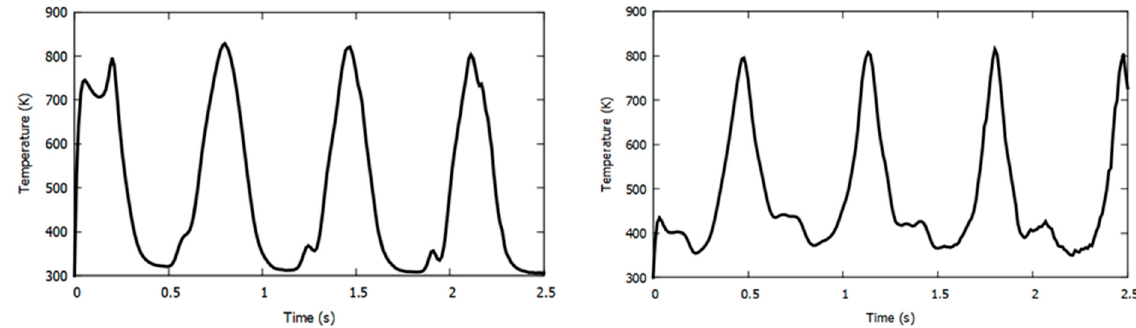
Figure 6. Temperature response of sensor Y31 ( left ) and sensor Y32 ( right ) at 3 a and 3 𝜔